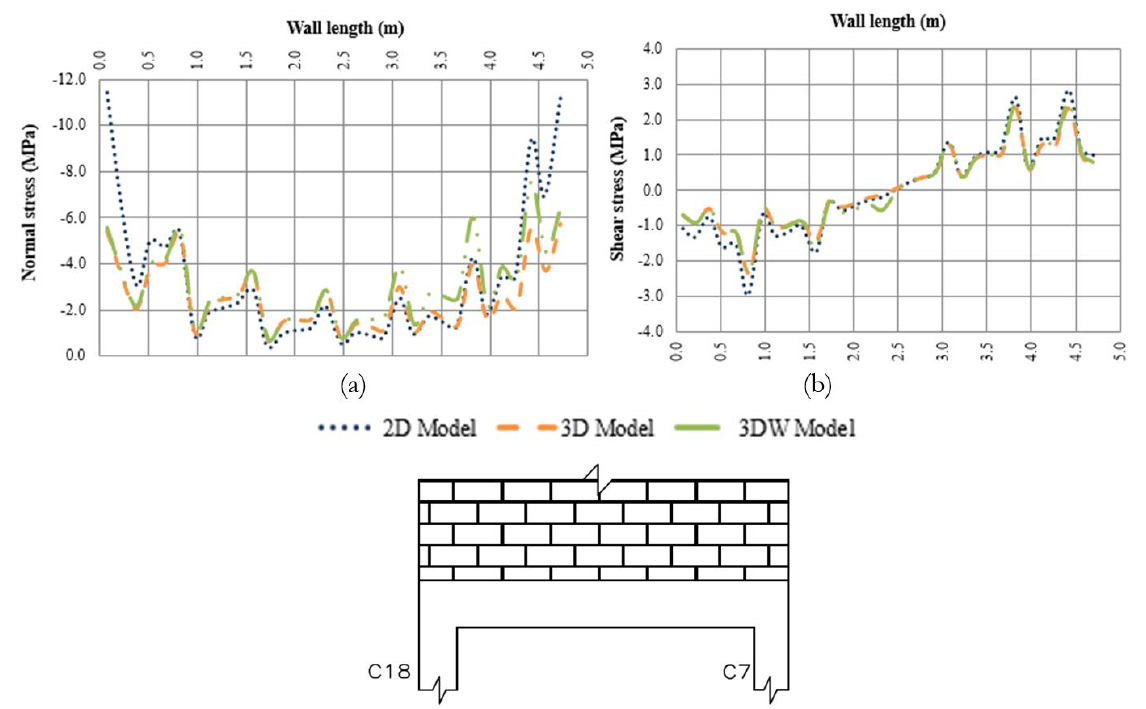
Figure 14. Stress distribution at the bottom of wall 41: (a) Normal stress; (b) Shear stress.